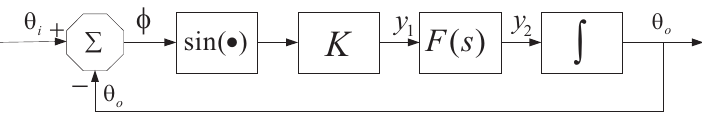
Figure 7. Model of the Phase-Locked